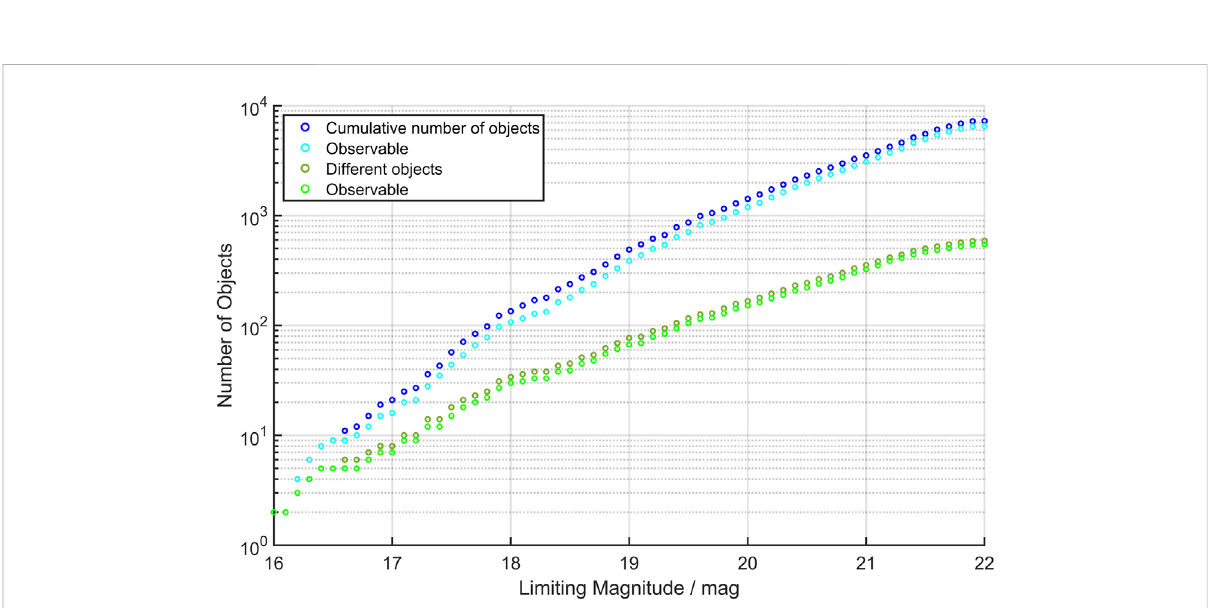
FIGURE 7 Numberofobjects intheNEOCC PriorityListwith amagnitude brighterthan aparticularLimiting Magnitude intheperiodfrom01.12.2021 until 31.01.2022. The cumulative number of all entries (with multiple entries of the same object in different nights) and the observable of them (blue), and the different objects (counted only once for multiple entries on different nights) of these (green) are